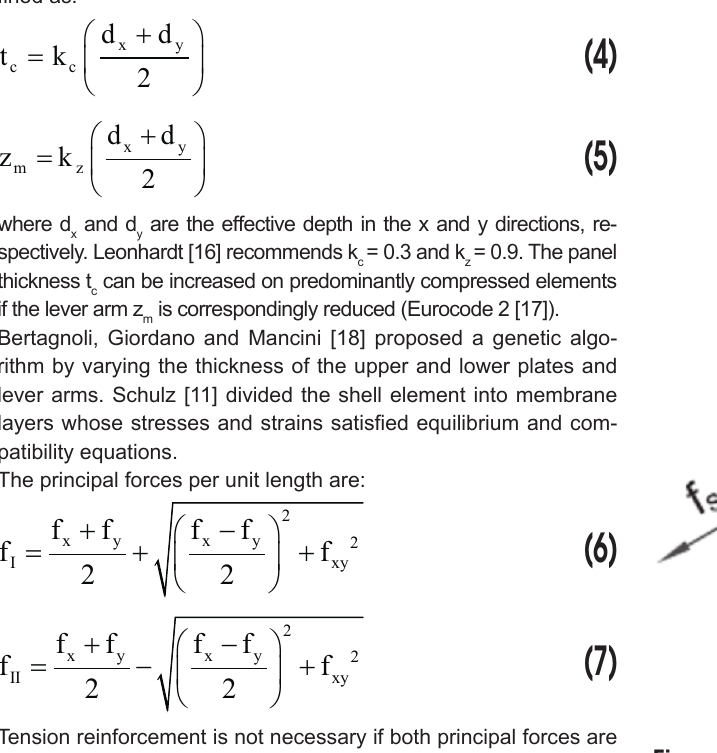
Figure 3 Forces per unit length in a skew reinforced concrete